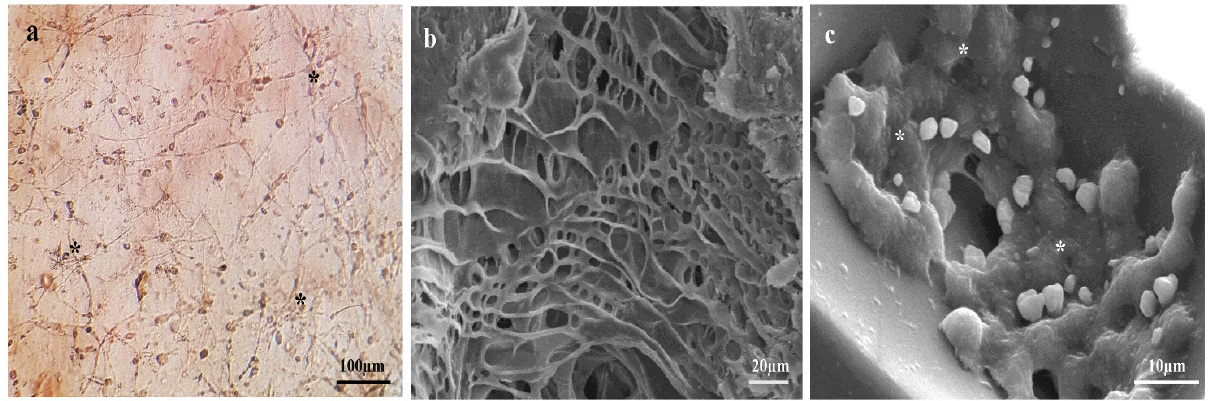
Figure 3. ( a ) An inverted microscopy picture of C-EnSCs cultured in fibrin gel. ( b ) SEM photo- graphs as a 3D open porous and interconnected porosity. ( c ) C-EnSCs attached and spread in the fibrin hydrogel. Stars indicate the location of cells in the gel.